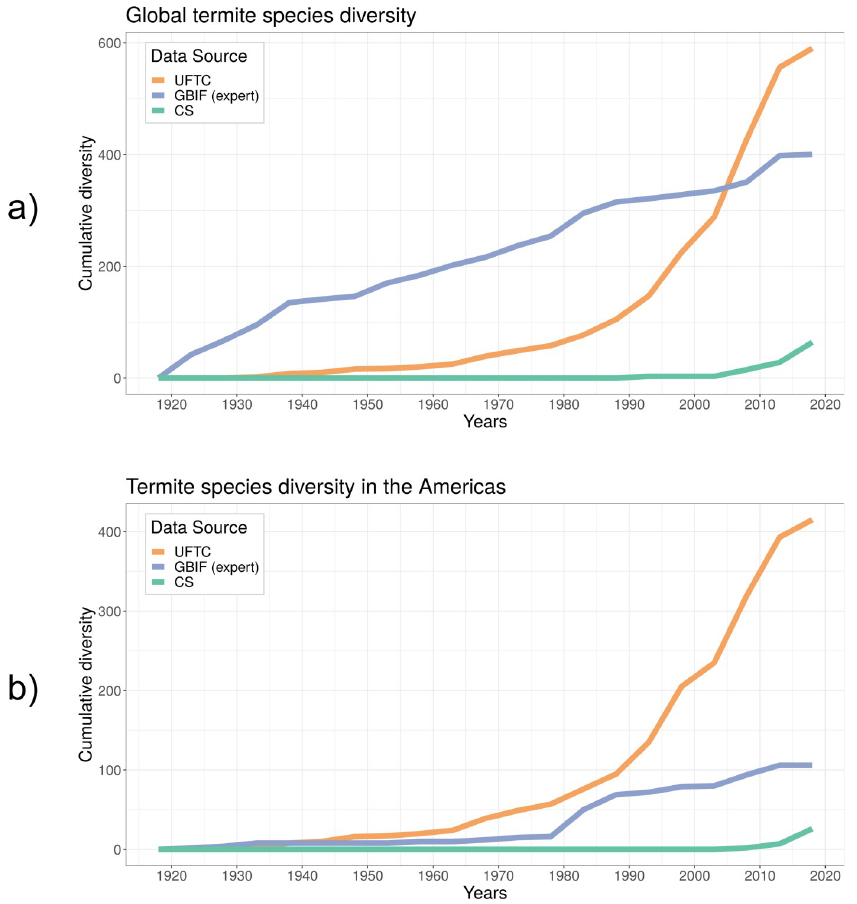
Fig 4. Cumulative number of termite species mapped in the UFTC, in GBIF based on expert (non-CS) observations and CS observations across the world (a) and in the Americas (b).